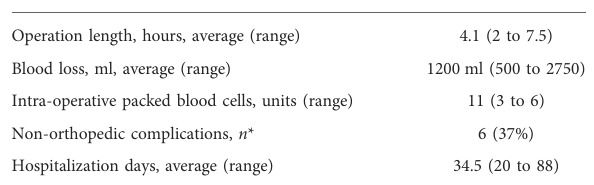
TABLE 3 Surgical results.